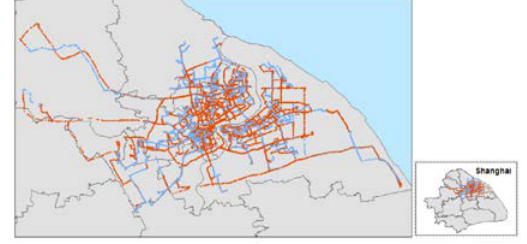
Figure 4. GPS samples of one taxi in one day, dots in red means the taxi is occupied, blue dots indicate non-occupied.